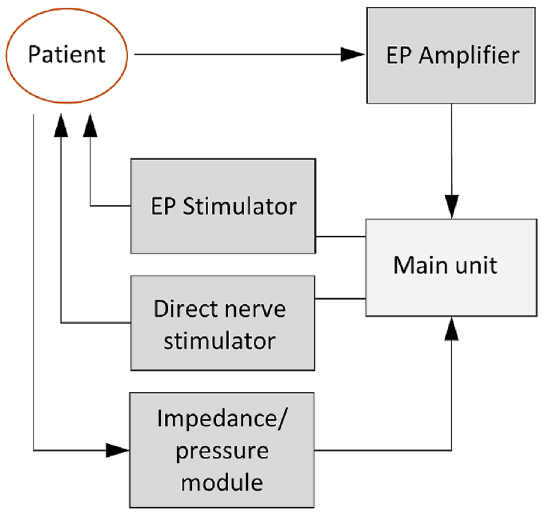
Figure 1. Components of the prototype of the neuromonitoring system AVALANCHE NeuroNeB for intraoperative pelvic neuromonitoring in a schematic. Direct nerve stimulator, impedance and pressure module are used for intraoperative identification of efferent pelvic autonomic nerves. Additional components are the EP stimulator and EP amplifier. The main unit controls the